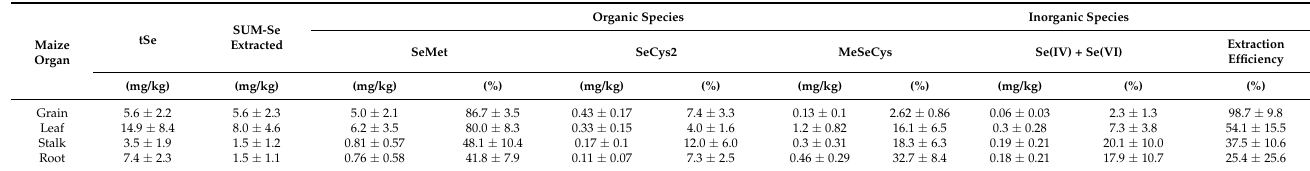
Table 2. Se species in enzymatic hydrolysis extracts and tSe of maize samples (in Se mg kg − 1 and % Se of species for tSe